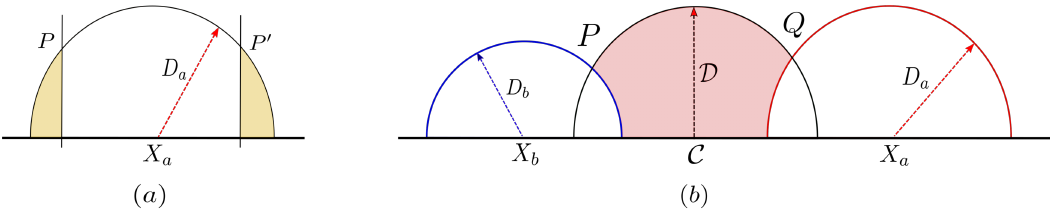
Figure 7. ( a ) Volume enclosed by a vertical line at P or P 0 and a half circle. ( b ) Volume under m 1 . where (cid:15) is the location of the cutoff surface, which ensures that we get a finite answer for the